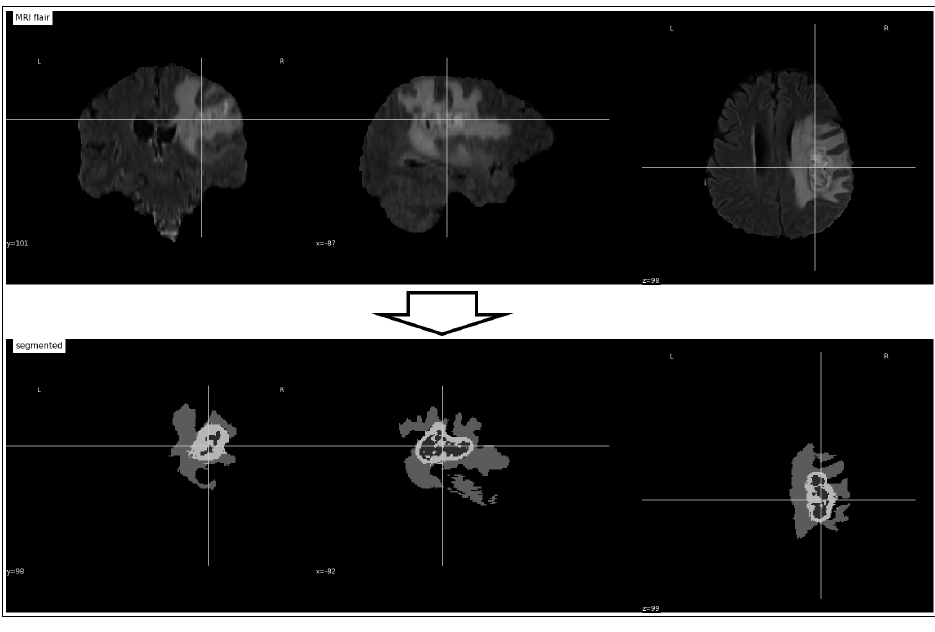
Figure 6. Example of the segmented tumor from the MRI.